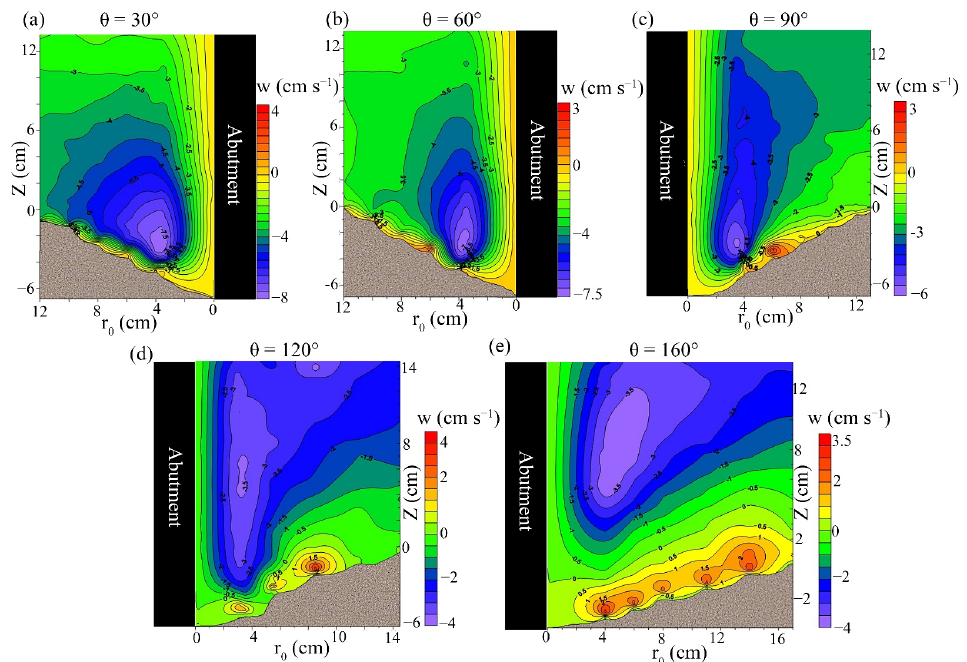
Figure 12. Velocity field in the vertical direction ( w , cm/s) for the case of the un-vegetated bed at different azimuthal angles of θ . Note that the range of the color scale is not equalized for better illustration.